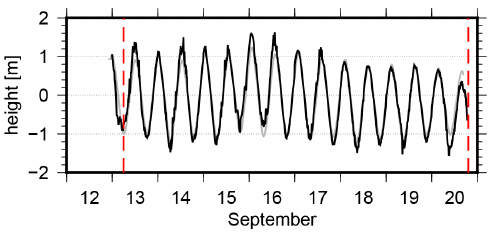
Figure 5. Estimated height coordinates during the stay at Tromsø (black); the Tromsø tide gauge record is plotted for comparison (gray); an empirically estimated height difference of 22.2m was subtracted from the GNSS positions; vertical red lines indicate RV Polarstern ’s arrival and departure times in